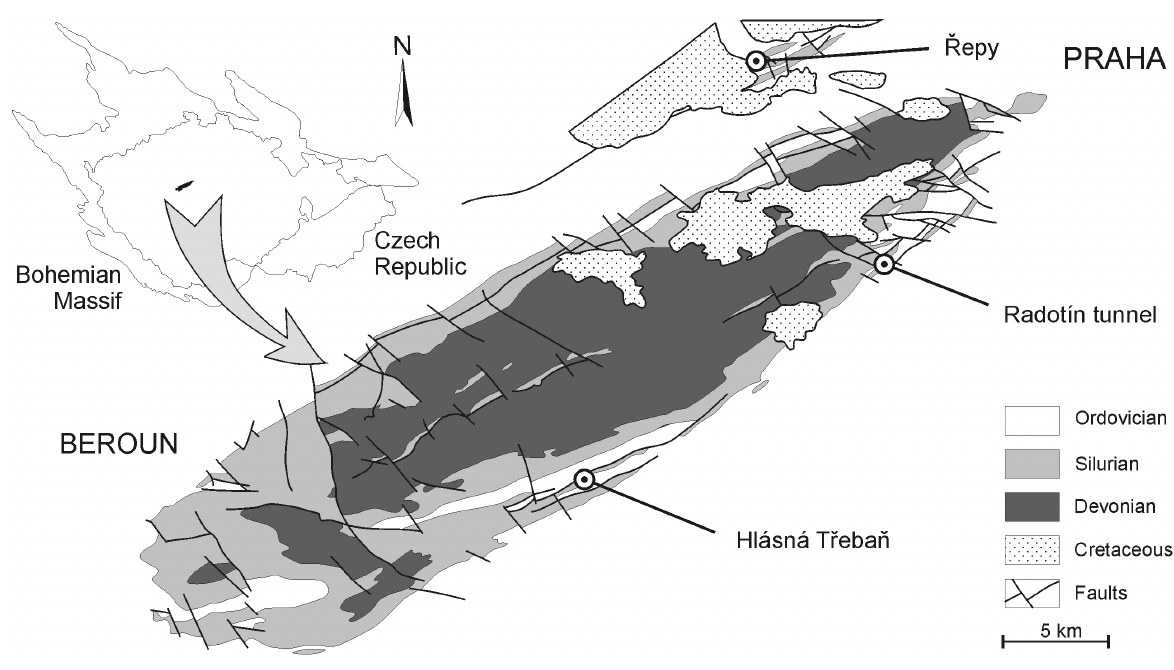
Fig. 1. Location of the sections referred to in the